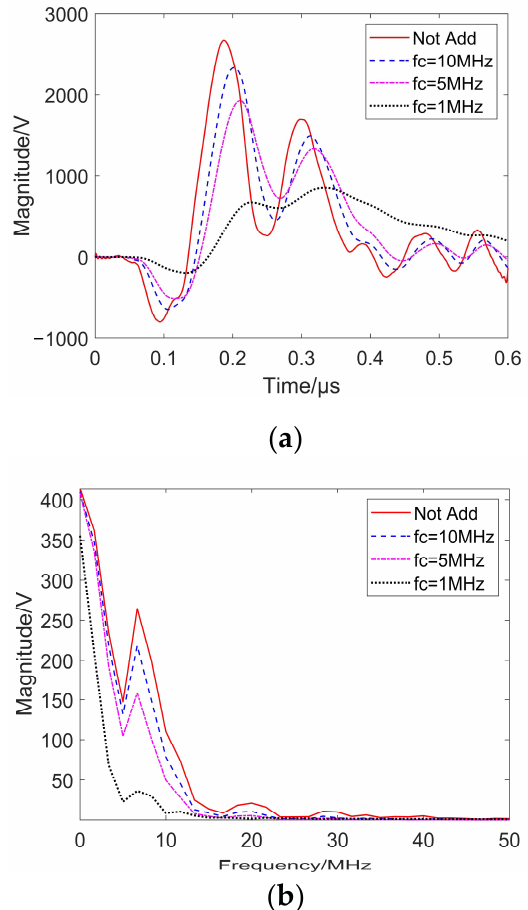
Figure 13. Disturbance voltage level after installing filter. ( a ) Time domain waveform; ( b ) spectro- gram.